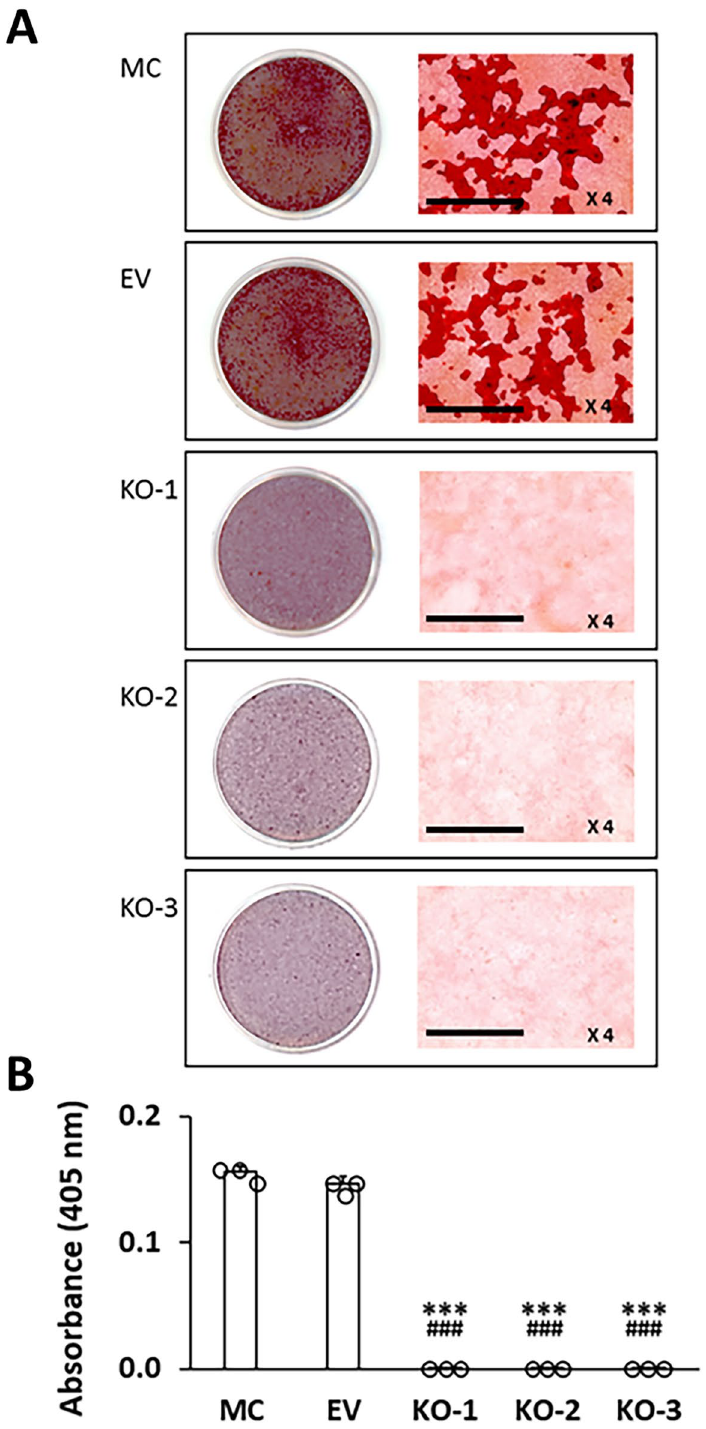
Figure 6. In vitro mineralization assay. ( A ) MC, EV, and KO clones were cultured in mineralization medium for 4 weeks. The cells/matrices were stained with Alizarin Red S. In the present study, an objective with a magnifying power of 4 was used to obtain the images. Scale bar represents 100 µm. ( B ) Quantification of Alizarin Red S contents. The contents were measured by absorbance at 405 nm. Values represent mean ± S.D. (n = 3) from three independent experiments. Statistical differences were determined by the method described above (Fig. 1. legend). *** p < 0.001 between MC and KO; ### p < 0.001 between EV and KO. MC MC3T3-E1, EV empty vector, KO